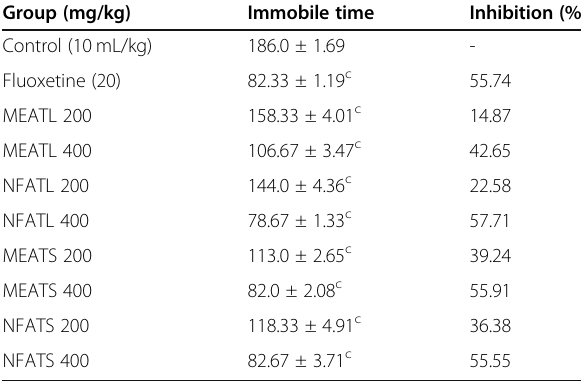
Table 4 Antidepressant activity of different extracts of A. trilobata on tail suspension test in